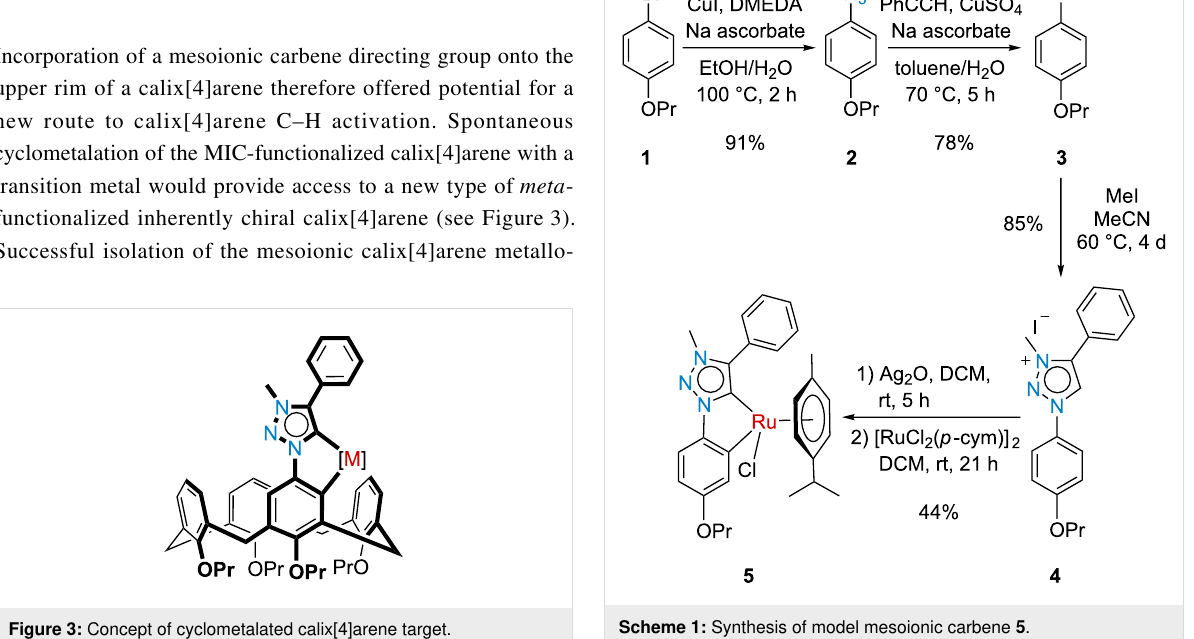
Figure 2: General approach by Albrecht for MIC directed cyclometala- tion via C–H activation; M = Ru(II), Ir(III) or Rh(III).